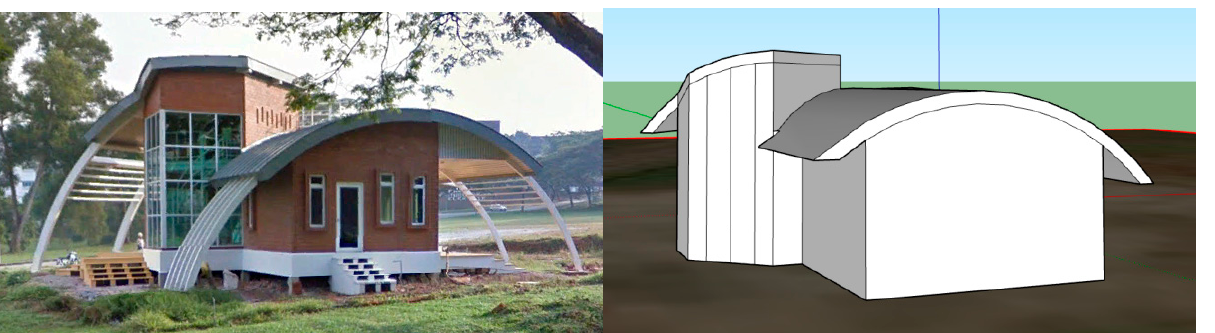
hand. More accurate data are required to achieve a higher scale of 3D models, such as point cloud data.